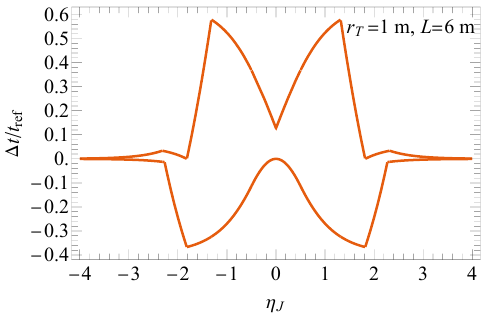
Figure 13 . The boundaries for the relative time difference as a function of η J . This can be compared with the boundaries in figure 9.